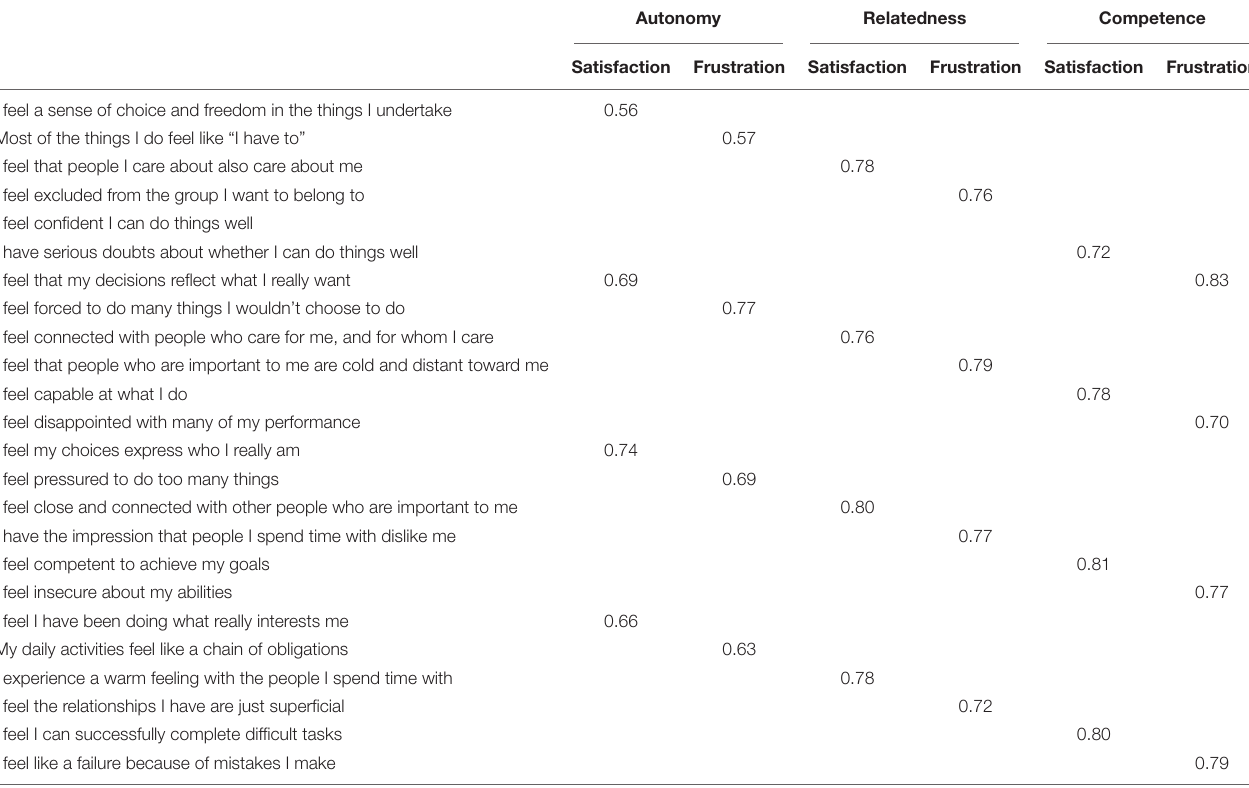
TABLE 3 | Standardized regression weighs in confirmatory factor analysis (CFA) of the 24 items of the Basic Need Satisfaction and Frustration Scale ( N = 259, Study